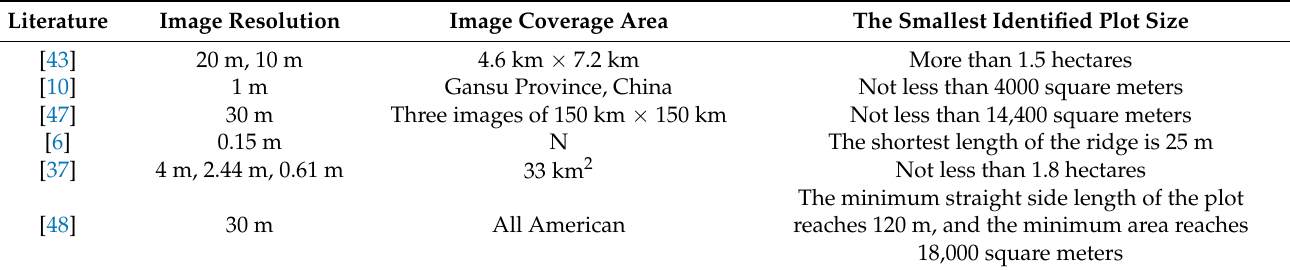
Table 17. Studies focusing on the flatness of the